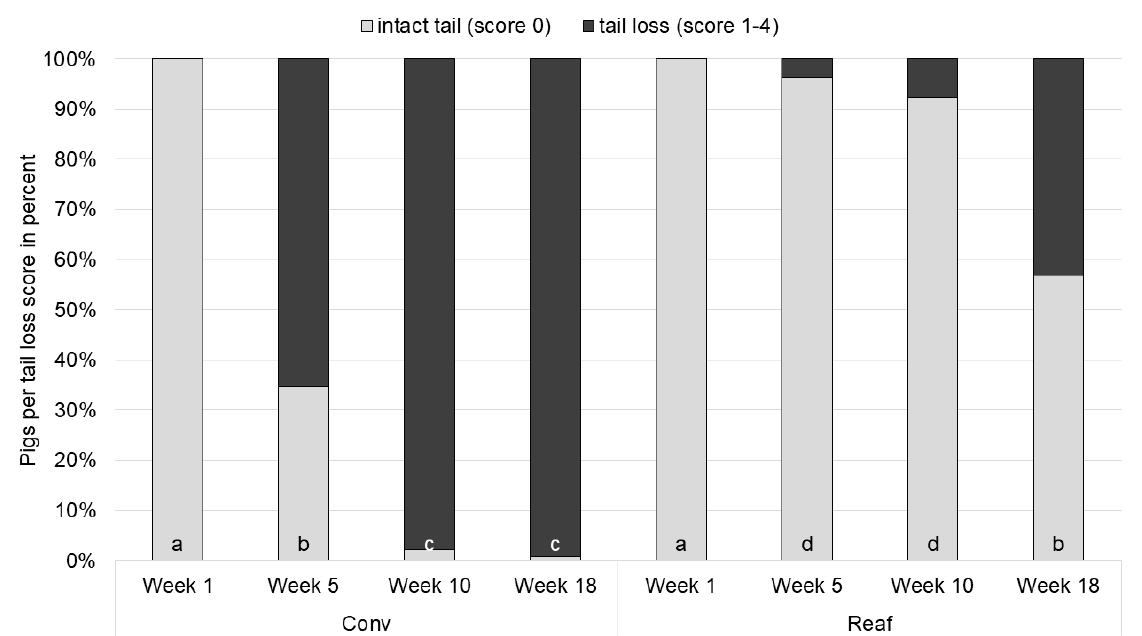
Figure 5. Frequency in percent of back transformed tail loss estimates of the interaction of rearing system × assessment week of undocked pigs (Conv: conventional rearing; Reaf: rearing in the farrowing pen; a–d: different letters indicate significant differences of score 0 (no losses) across housing system and assessment week ( p < 0.05).